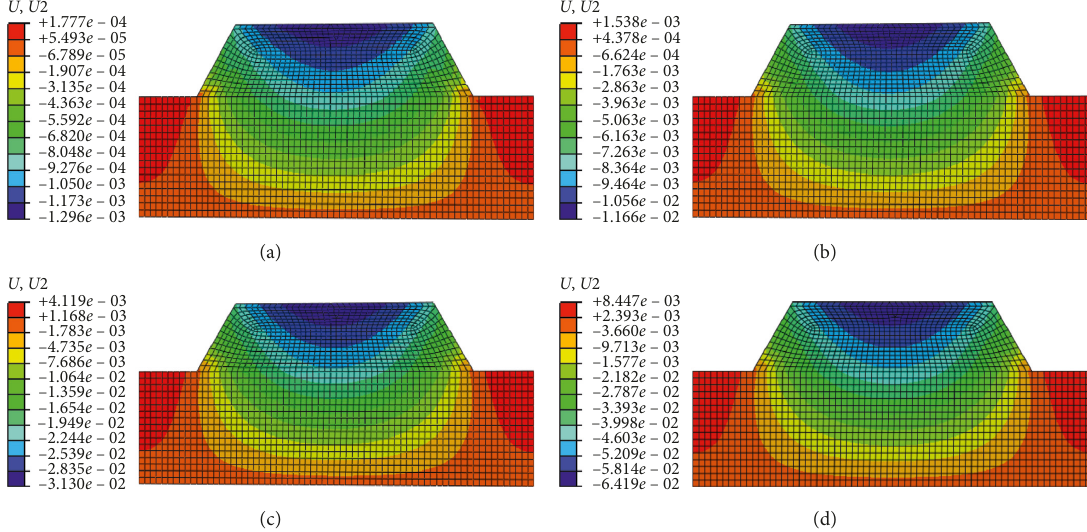
Figure 9: The postconstruction settlement of the compacted embankment (unit: m). (a) Settlement at the completion of filling. (b) Settlement after 1year of operation. (c) Settlement after 5years of operation. (d) Settlement after 10years of operation.